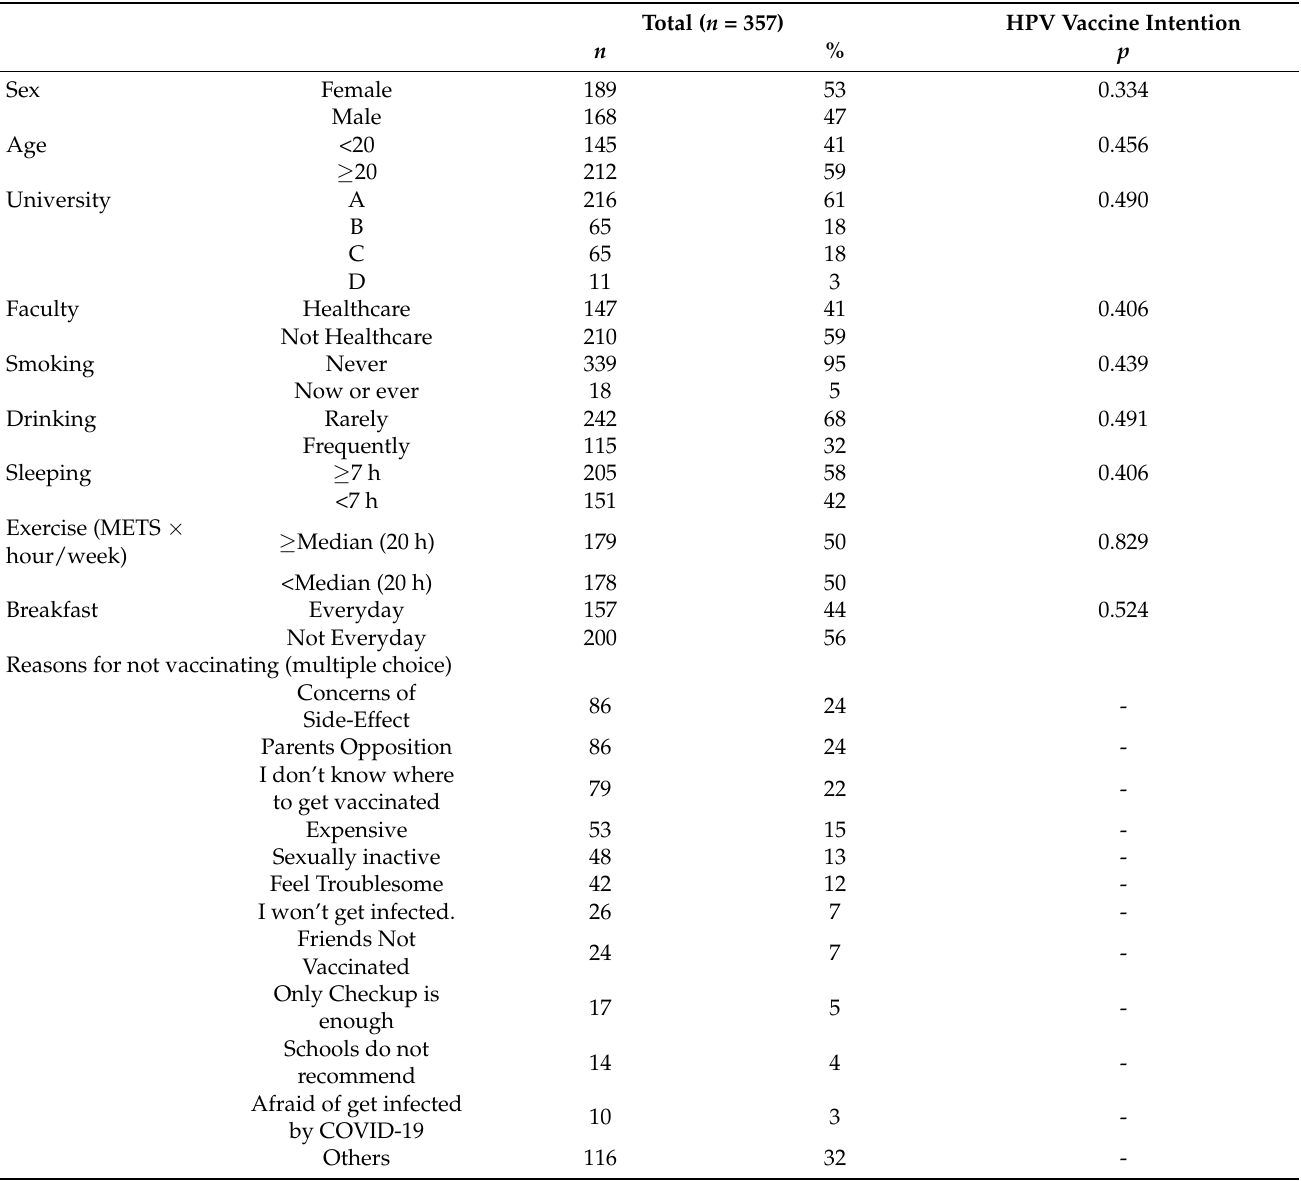
Table 1. Baseline characteristics ( n =